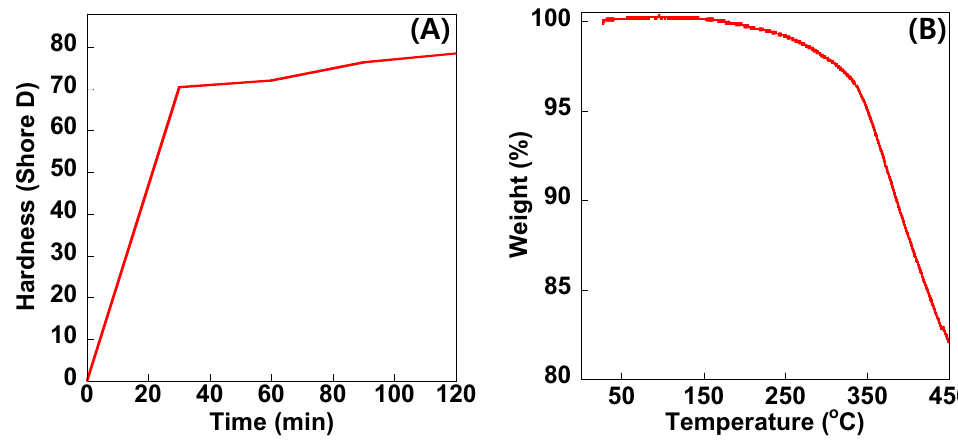
Figure 2. Graph for the hardness (Shore D) of the PSH according to the curing times ( A ) and TGA analysis of the PSH ( B ).